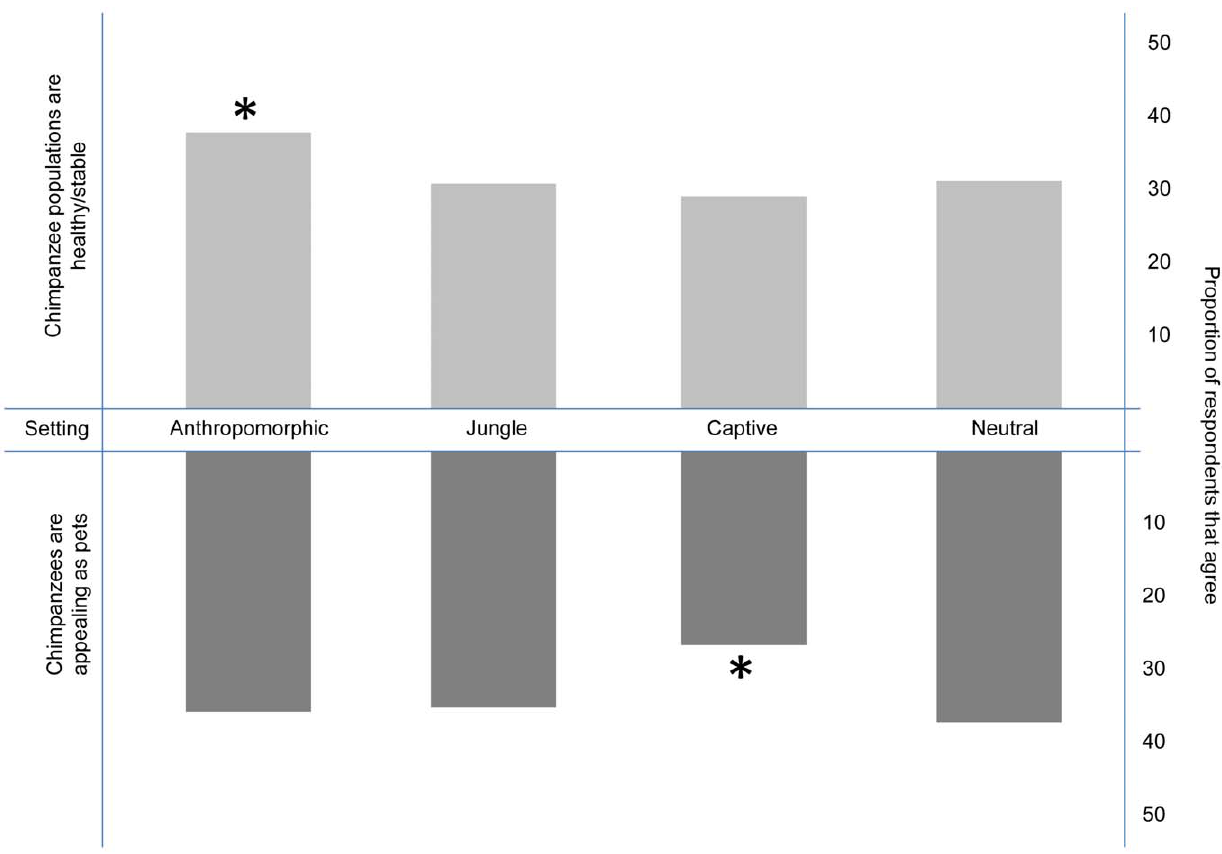
Figure 3. Effect of human presence on perception of chimpanzees as appealing pets. Detailed legend: The top bars display the proportion of survey respondents that agreed that wild chimpanzee populations were healthy/stable when viewing one of four versions of a composite image: those with an anthropomorphic (office setting) background, a jungle background, a captive (zoo setting) background, or a neutral (blank white) background. The bottom bars display the proportion of survey respondents that agreed that chimpanzees were appealing as pets after viewing one of the same images with one of the four above-listed backgrounds.